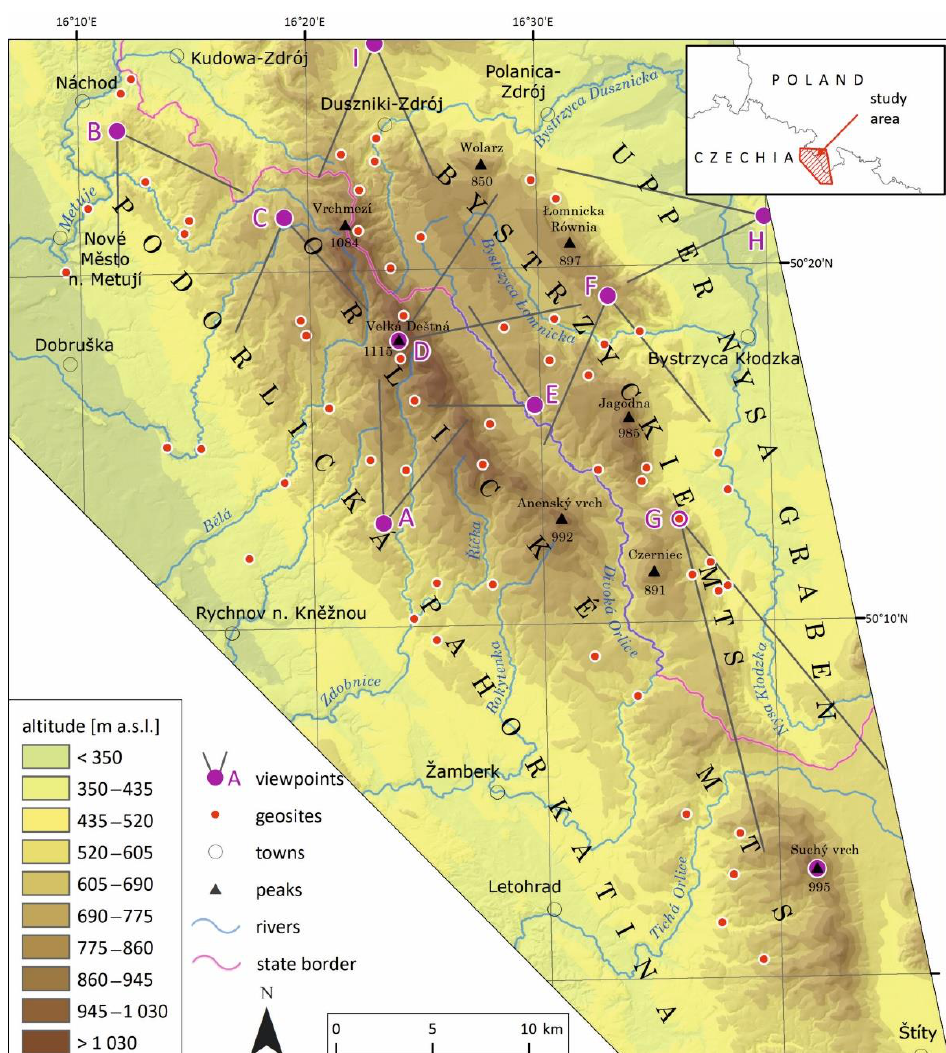
Figure 5. Location of panoramic viewpoints in the Orlické–Bystrzyckie Mountains Block. Letter codes consistent with Table 4 and Figure 6.